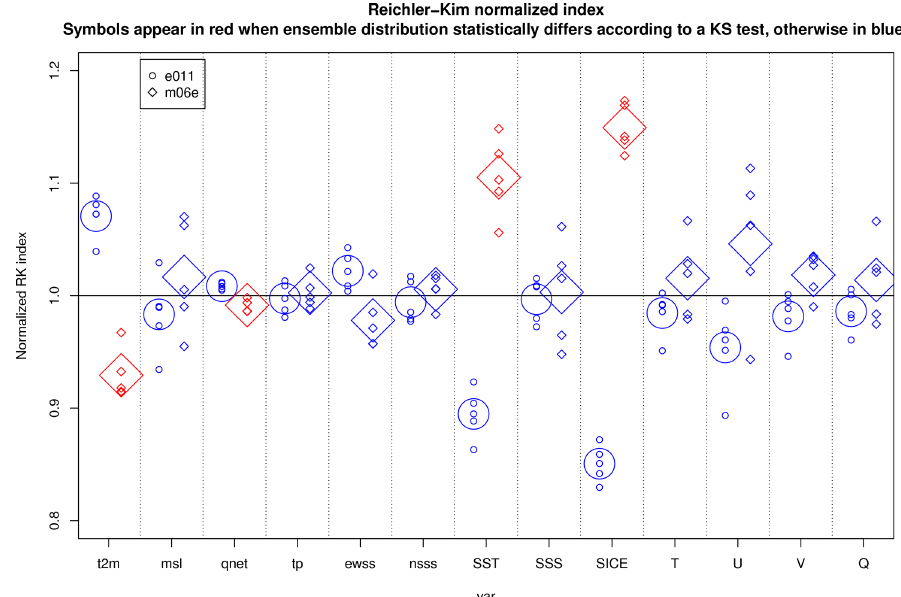
Figure 3. Distribution of the normalized Reichler and Kim (2008) metrics for the two simulations e011 (EC-Earth 3.1 on ECMWF-CCA, circles) and m06e (EC-Earth 3.1 on MareNostrum3, squares) for 13 fields: 2m air temperature (t2m), mean sea level pressure (m.s.l.), net thermal radiation (qnet), total precipitation (tp), zonal wind stress (ewss), meridional wind stress (nsss), sea surface temperature (SST), sea surface salinity (SSS), sea ice concentration (SICE), 3-D air temperature ( T ), 3-D zonal wind ( U ), 3-D meridional wind ( V ), and specific humidity ( Q ). The metrics appear in red when the distribution of m06e is statistically incompatible (in the sense of the KS test; see Sect. 3.2.3) with the e011 distribution. The significance level of the KS test is set to 5%.